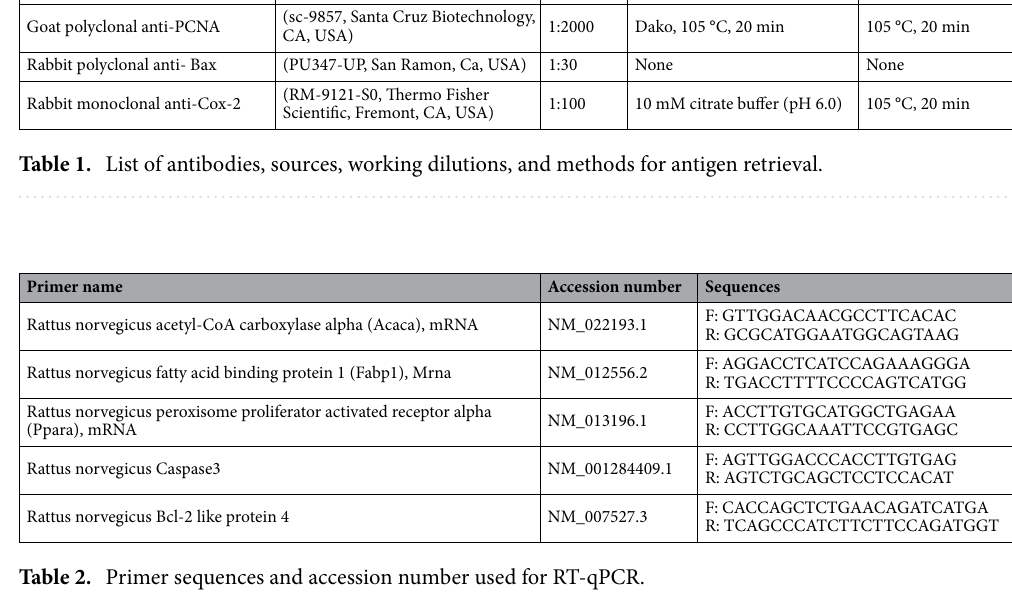
Table 2. Primer sequences and accession number used for